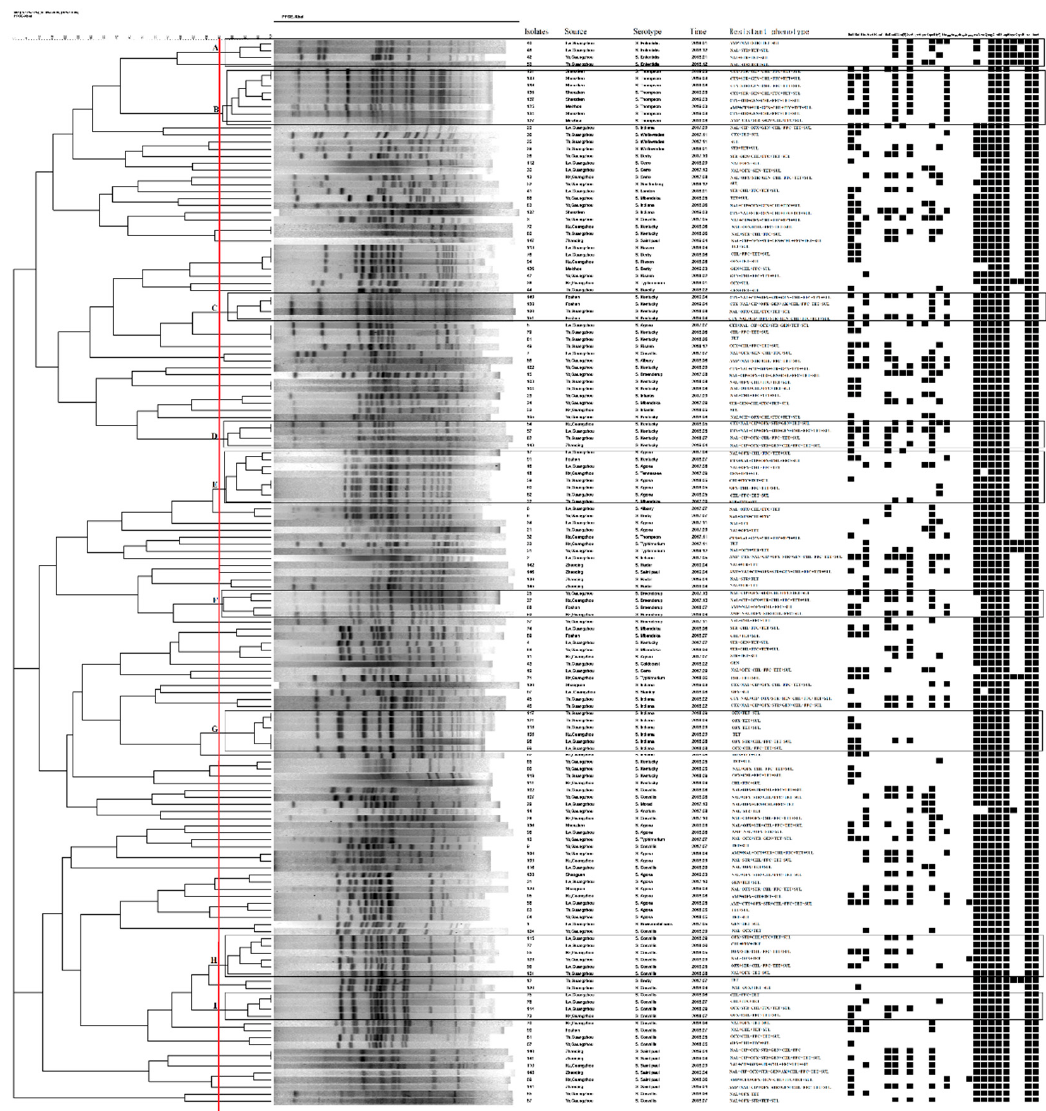
Figure 2. Dendrogram of PFGE patterns of 151 Salmonella isolates from retail duck meats in Southern China showing the antibiotic resistance phenotype, resistance genes and virulence gene patterns. A black box indicates carrier-related genes.